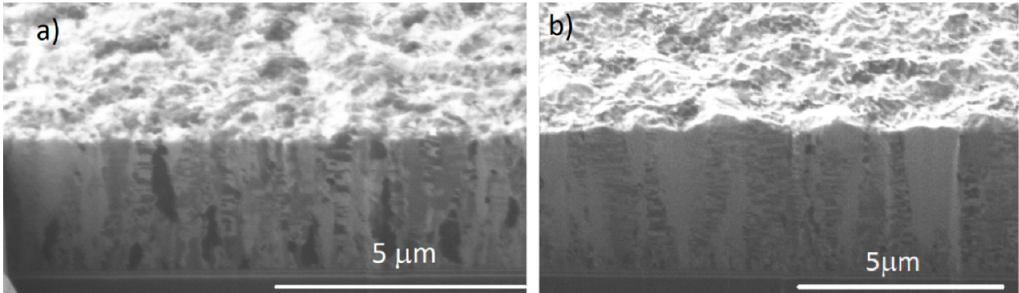
Figure 2. Cross-sectional focused ion beam (FIB) images showing the microstructures for the Au film deposited of ( a ) on-off time 40 ms:4 ms ( b ) on-off time 40 ms:20 ms. Thicknesses are approx. ( a ) 3.4 and ( b ) 4.8 µm.